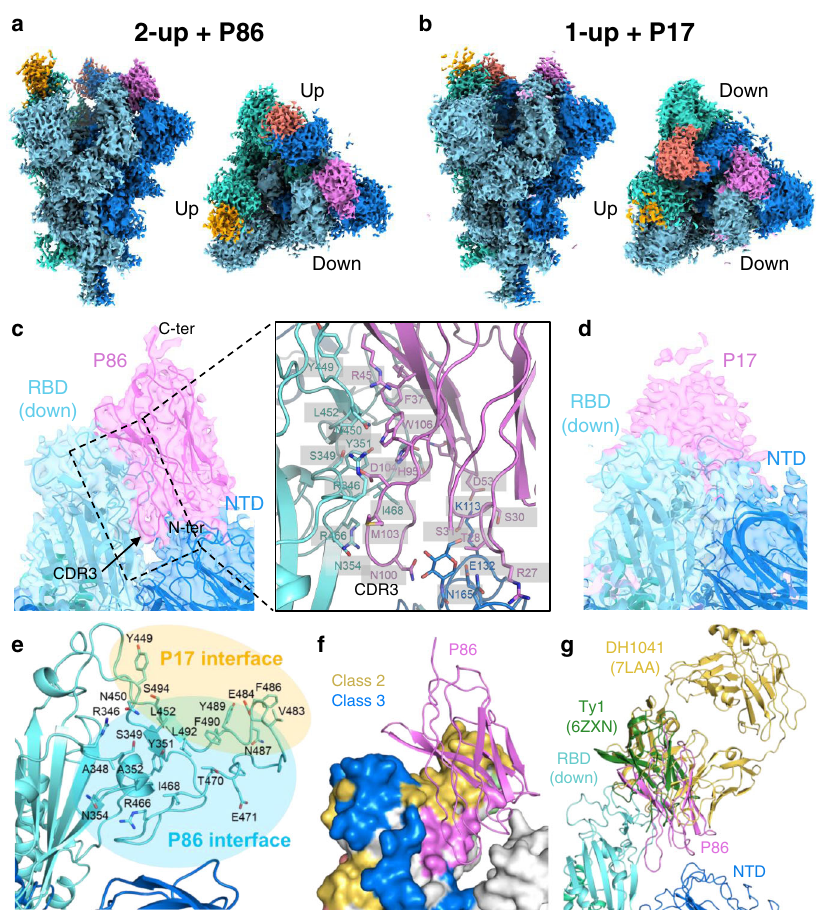
Fig. 6 Cryo-EM density maps of SARS-CoV-2 spike-P86 and SARS-CoV-2 spike-P17 complexes. a , b Final sharpened maps of the ( a ) 2-up + P86 and ( b ) 1-up + P17 datasets. The map regions corresponding to one protomer in the spike protein are coloured differently in cyan, blue, and turquoise. The map regions corresponding to one P86 or P17 molecule bound to the RBD regions are coloured magenta, red, and orange, respectively. c Close-up view around P86 bound to the down-RBD with our fi tted model. Right panel shows close-up view around the interface among P86, the down-RBD, and the NTD of the neighbouring protomer. d Close-up view around P17 bound to the down-RBD. The model of D614G spike trimer (PDB entry: 7KRR) was fi tted on the maps 95 . e The residues located on the interface between the down-RBD and P86 or P17. f Epitope mapping on the down-RBD. The epitopes of Class-2, Class-3 and P86 are shown in yellow, blue, and magenta, respectively. The colouring priority of the overlapping region is Class-3 > Class-2 > P86. The model of P86 is a ribbon structure. g Structure comparison with other antibodies bound to the down-RBD. The structures are superposed on the single RBD For structural analyses, the sequence encoding the spike ectodomain (residues 1 – 1208) with proline substitutions, a “ GSAS ” substitution at the furin cleavage site (residues 682 – 685) 75 , and the C-terminal foldon trimerization motif followed by an 8×His-tag was cloned into the pcDNA3.1( + ) expression vector. Furthermore, the D614G mutation in the spike protein was introduced by the inverse PCR method. For cryo-EM, recombinant spike proteins were transiently expressed in Expi293-F cells (Thermo) maintained in HE400AZ medium (Gmep, Inc., Fukuoka, Japan). The expression vector was transfected using a Gxpress 293 Transfection Kit (Gmep) according to the manufacturer ’ s protocol. The culture supernatants were harvested 5 days post-transfection. The C-terminally 6×His-tagged spike proteins were puri fi ed using a nickel Sepharose 6 FF column (Cytiva) and size exclusion chromatography using a Superdex200increase 10/300 GL column (Cytiva) with buffer containing 50 mM HEPES (pH 7.0) and 200 mM NaCl.